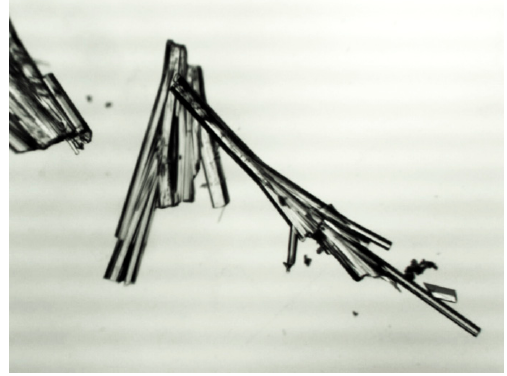
Figure 10. Crystals of the title Compound ( 3 ).